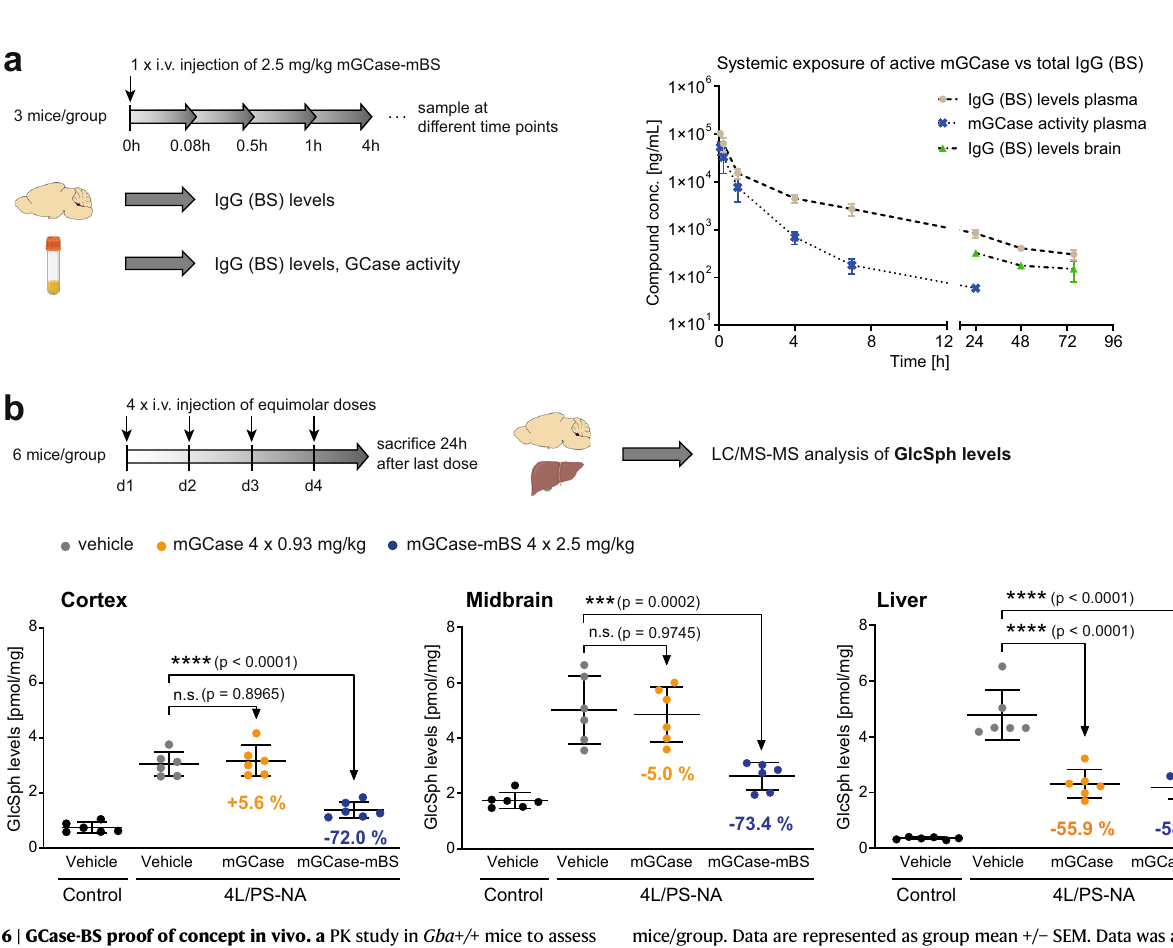
mice/group. Data are represented as group mean +/ − SEM. Data was analysed by one-way ANOVA (Dunnett ’ s multiple comparisons test) comparing each treatment group to 4L/PS-NA, vehicle. n.s. p >0.05; **** p <0.0001. Source data are provided as a Source Data fi le. Schematics created with